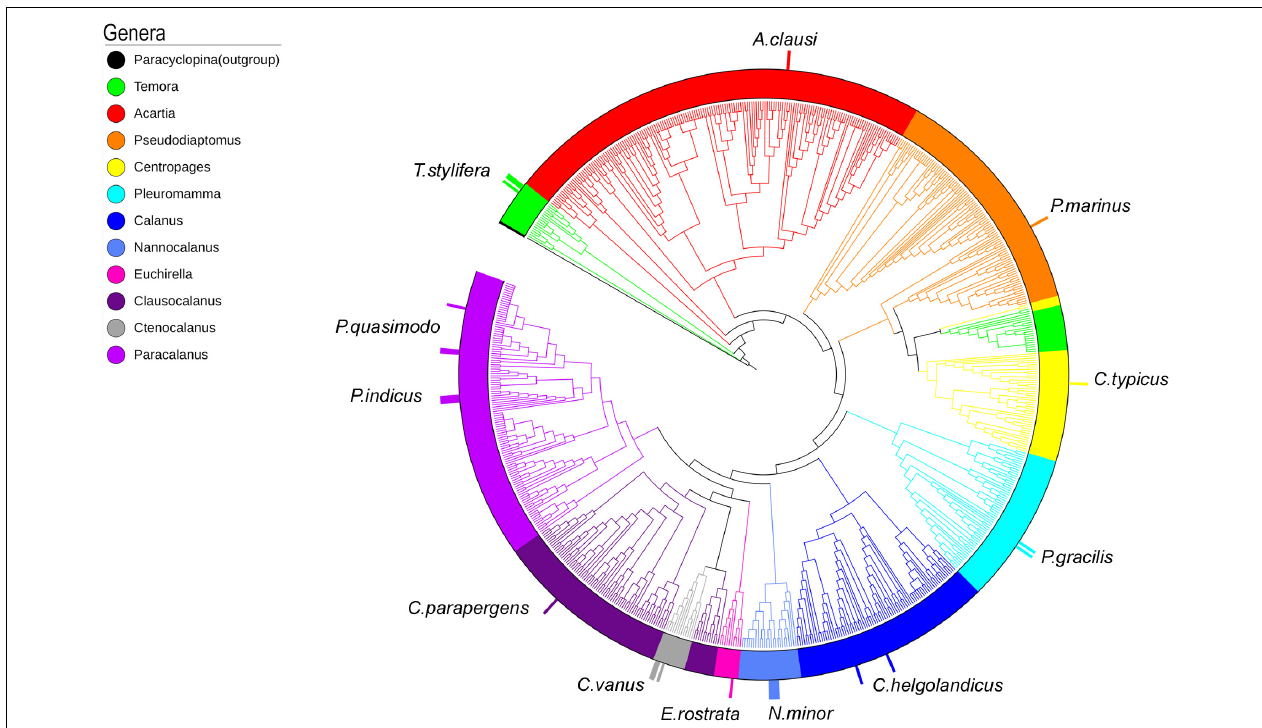
FIGURE 4 | ML tree of 717 COI reference sequences from BOLD and 25 barcodes generated (taller bars). Outgroup: Paracyclopina nana